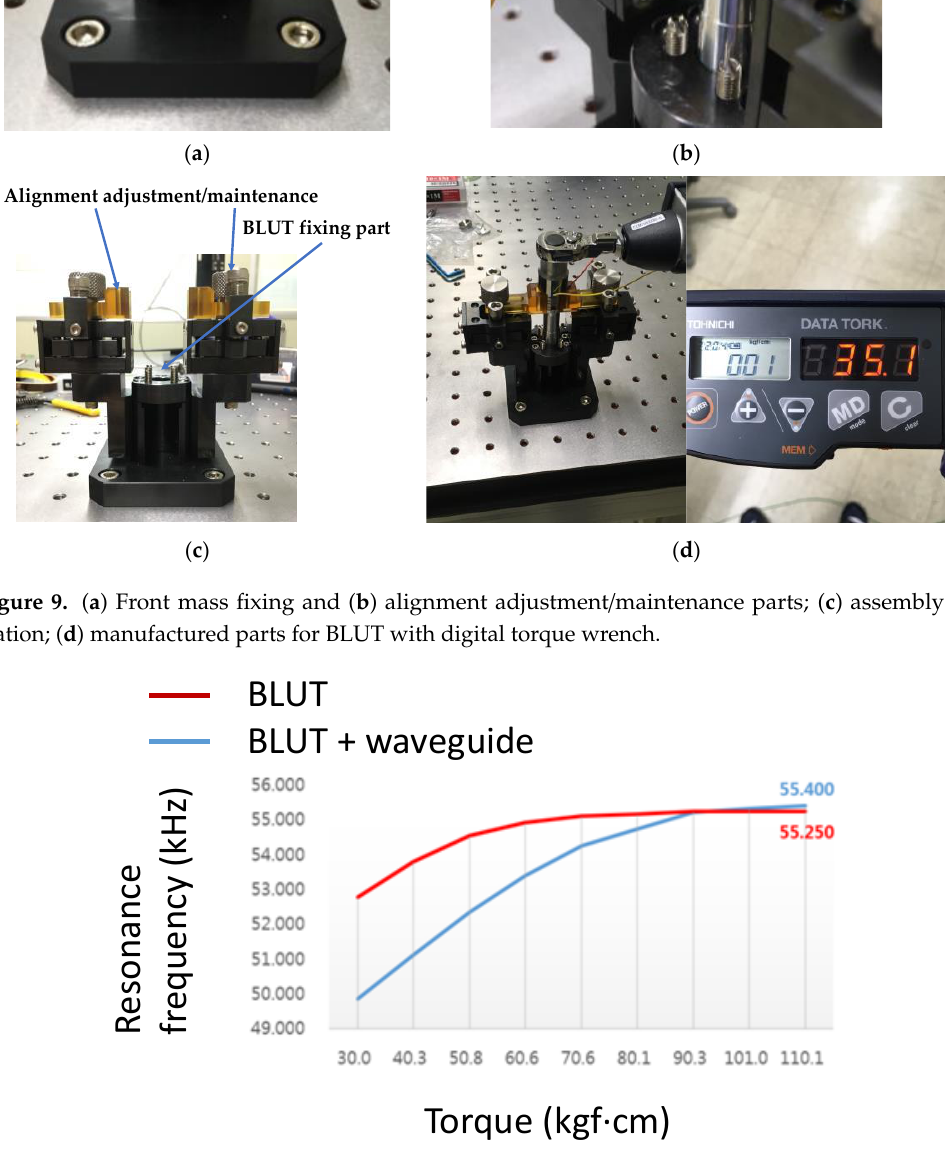
Figure 10. Resonance frequency of the BLUT with and without waveguide.